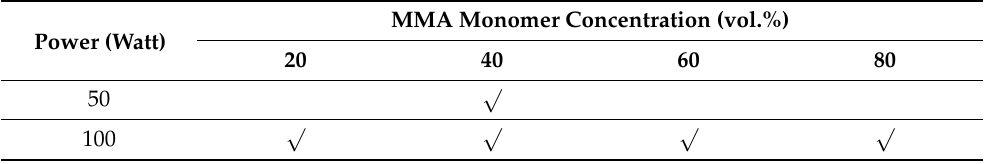
Figure 3. Schematic methodology of PP-MMA-coated silicone tube for ATR-FTIR analysis. ( a ) The silicone tube is 8 cm in length with an internal radius of 3 mm. ( b ) Shows eight tube sections equally cut to be 1 cm in length. ( c ) Shows 1 cm tube section cut from the middle position to make a flat sample for ATR-FTIR analysis. ( d ) Shows flat silicone tube for ATR-FTIR analysis.